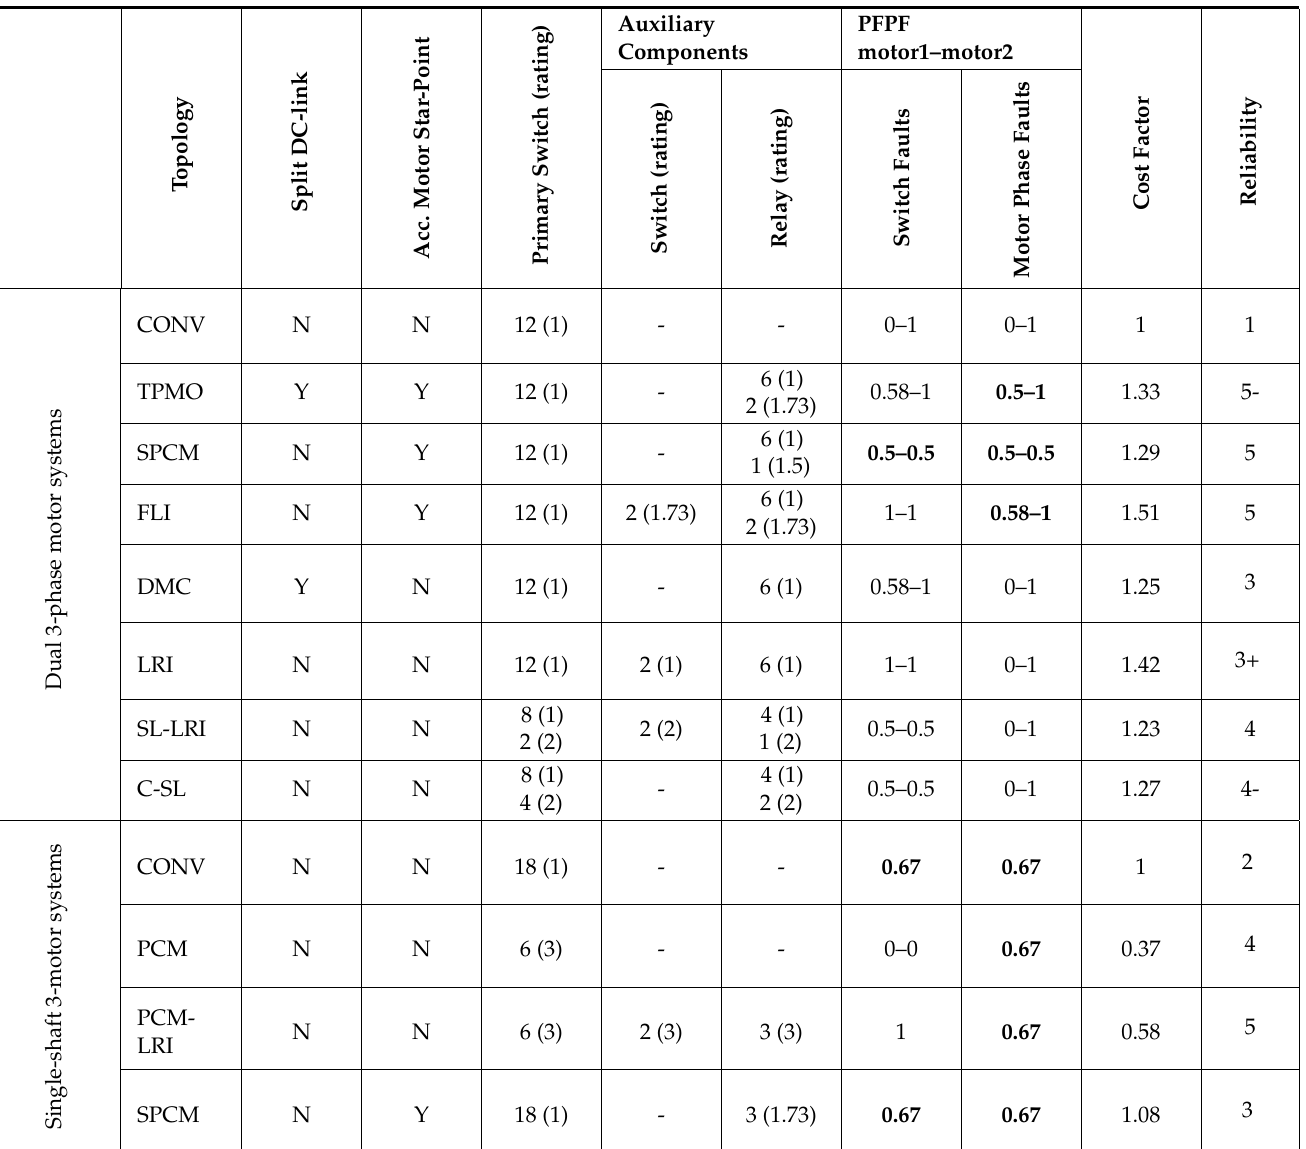
Table 1. Performance factors and assessment figures of proposed topologies.